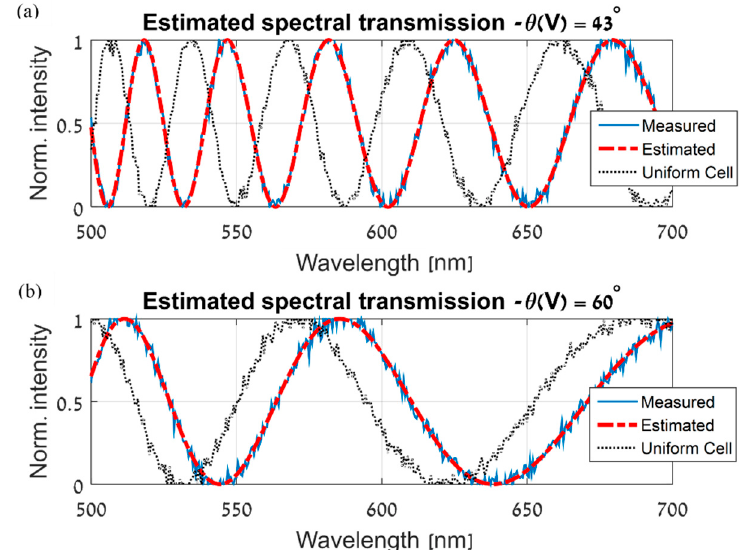
Figure 8. ST spatial estimation results at di ff erent voltages and locations on the simulated LCC. In each of ( a , b ), the continuous blue line is the measured ST at a specific location and voltage. The dashed red line is the estimated ST at the same location and voltage. Lastly, the dotted black line is the ST measured at the same voltage, but at the base location, demonstrating the error obtained without applying the proposed spatial estimation algorithm (that is, if a spatially uniform LCC is assumed, with a cell gap equal to the gap at the base location).